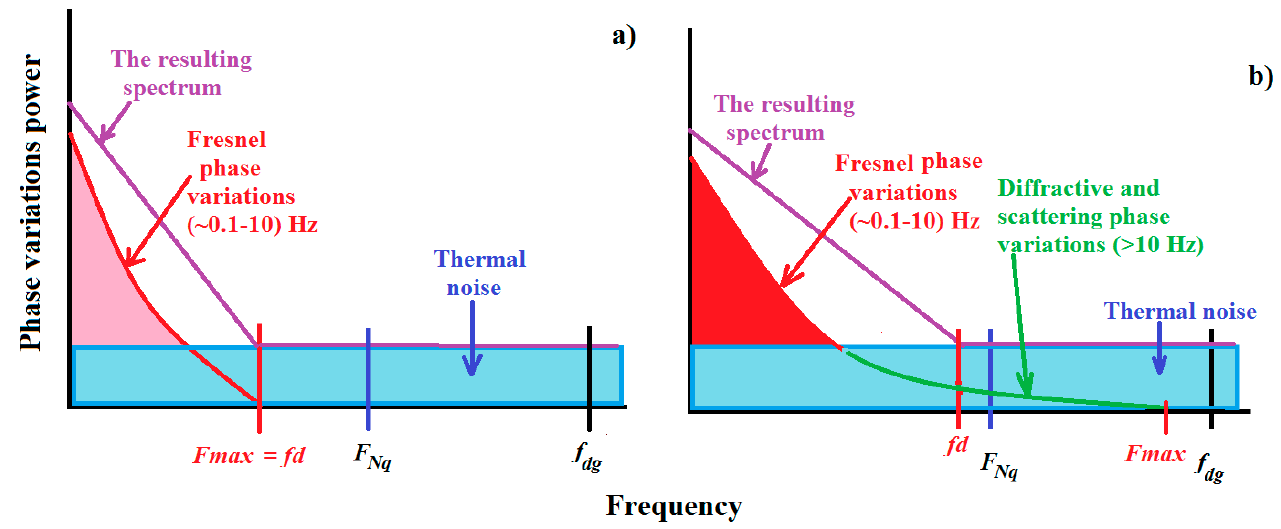
Figure 7. Impact of the effect of aliasing to the deviation frequency variation: in presence of refractive Fresnel variations only—panel ( a ); in presence of both refractive and diffractive phase variations—panel ( b ).